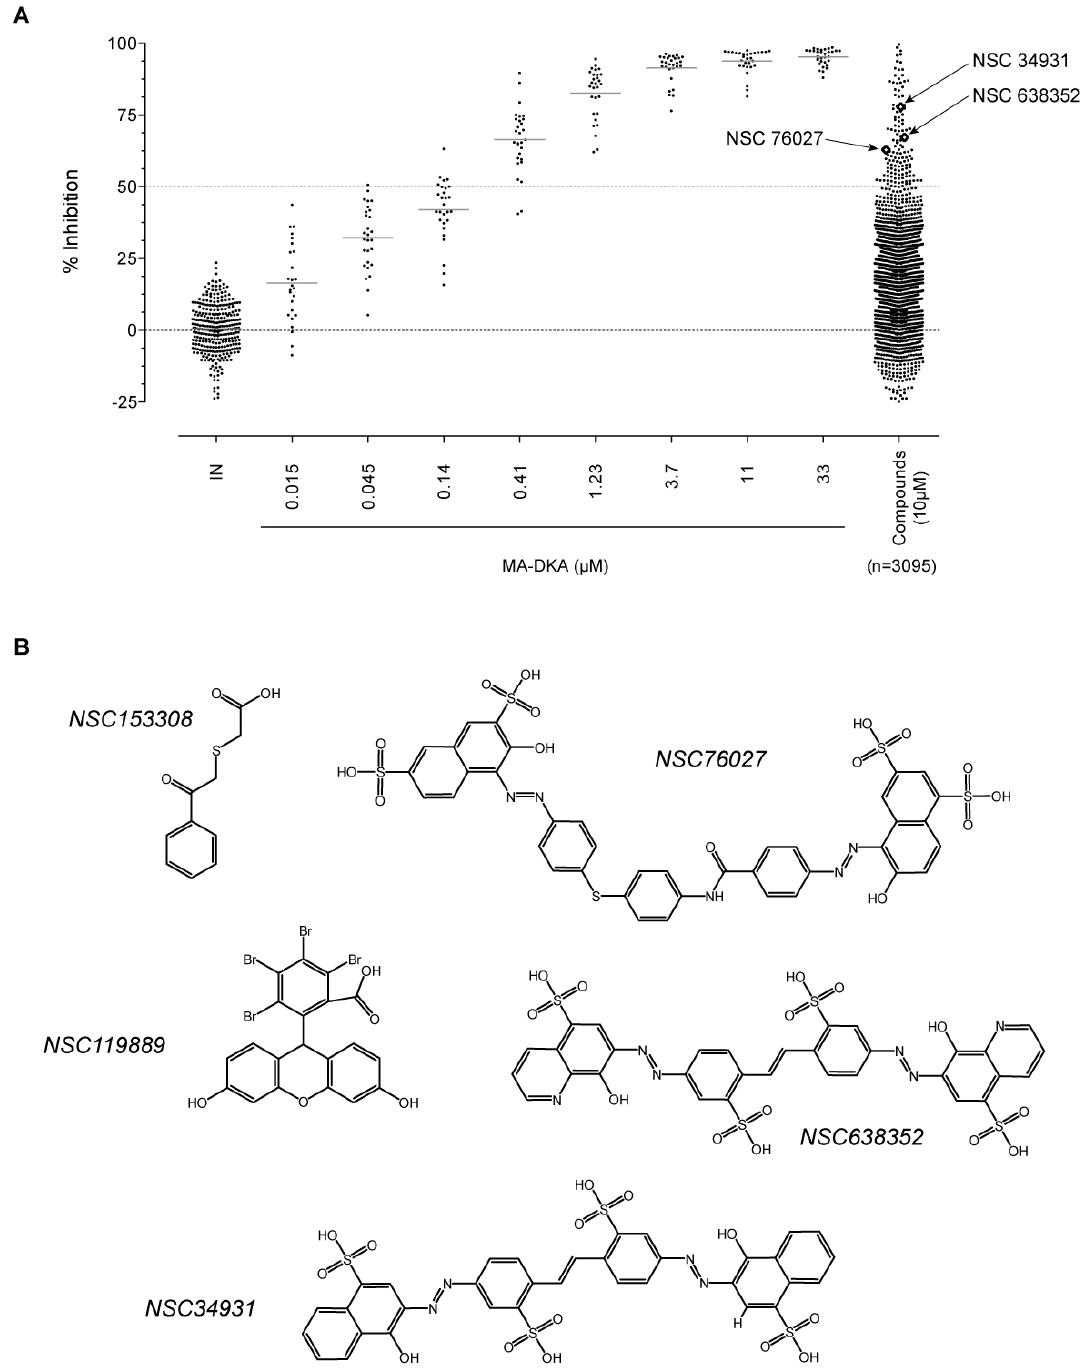
Figure 1. High-throughput screening of the National Cancer Institute Developmental Therapeutics Program’s 3095 small molecule plated sets from the Open Chemical Repository Collection. ( A ) Scattered plot summarizing the results of the electrochemiluminescent integrase (IN) ST screening assay. Experiments were performed in a 96-well plate format, where each plate harbored eight control points with DMSO (IN alone) and a dose response of MA-DKA (also known as 118-D-24) over eight concentrations. Altogether, the screen necessitated 39 assay plates. Open diamonds represent the three stilbene disulfonic acid derivatives identified by the screen. ( B ) Chemical structure of the two top hits and the three stilbene disulfonic acid derivatives.